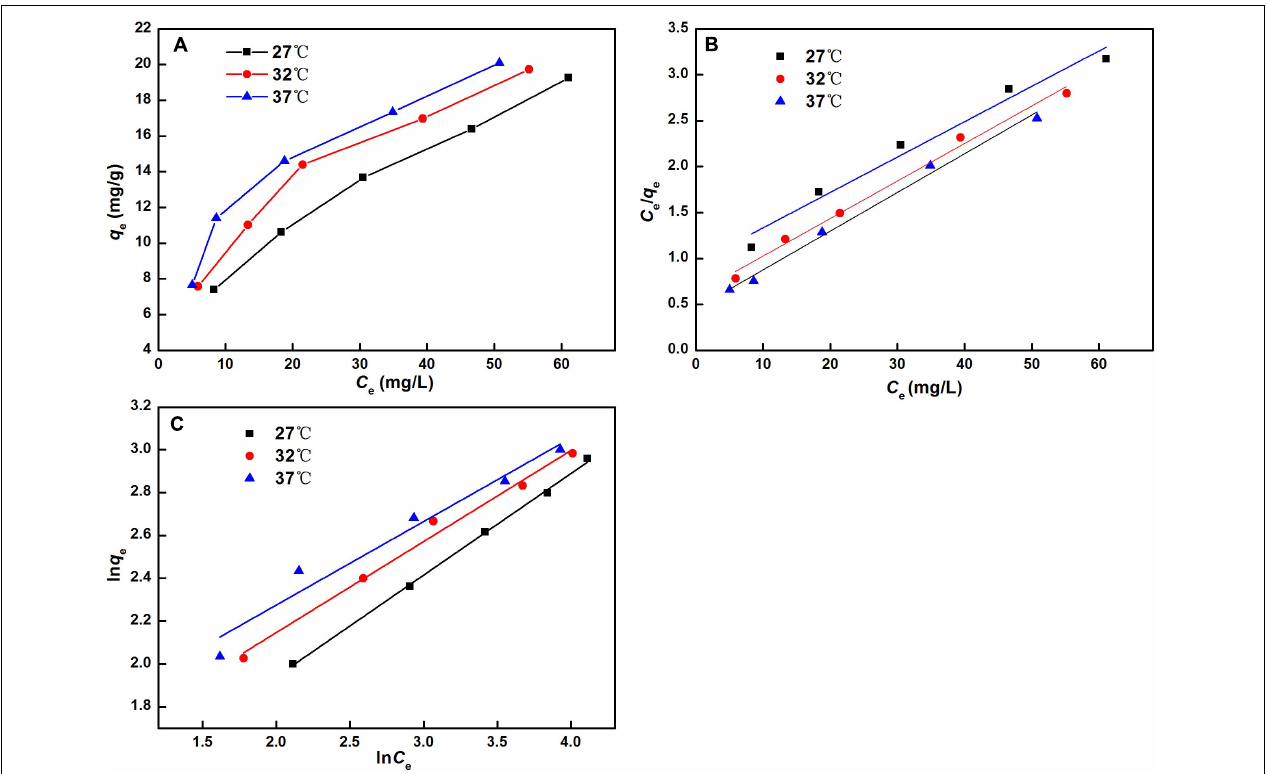
FIGURE 4 | Adsorption isotherms (A) , linear correlations based on the Langmuir (B) and Freundlich (C) models of HSAF on the NKA at different temperatures.